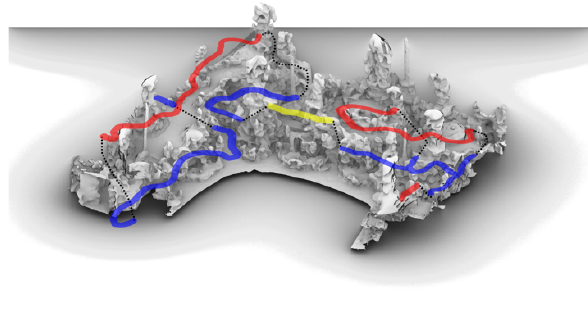
Figure 8. The paths showing.